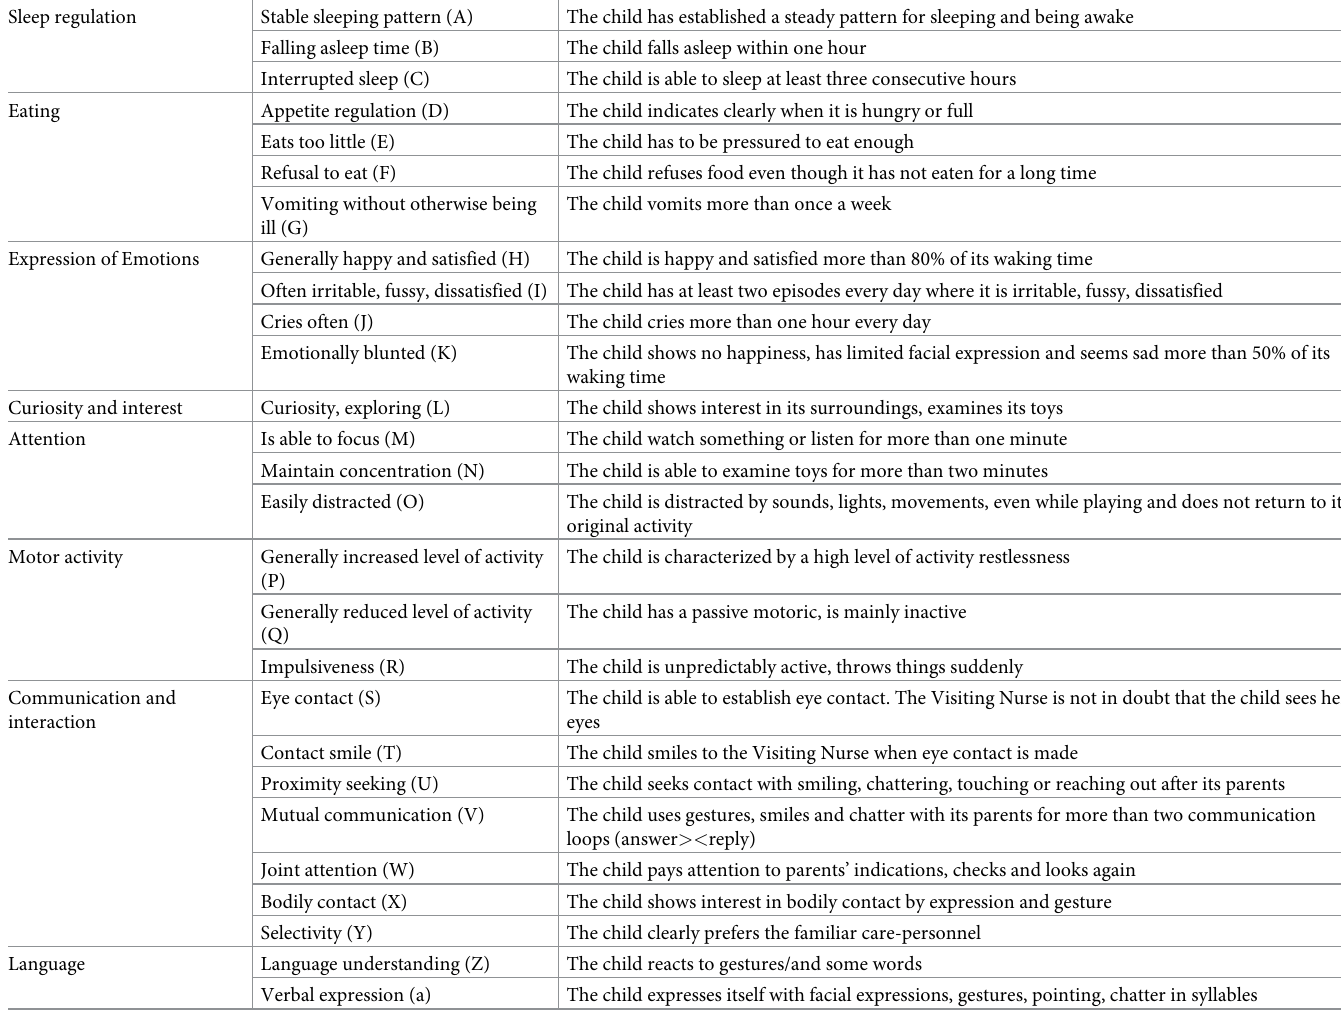
Table 1. The Copenhagen Infant Mental Health Questionnaire domains, items and descriptions of items. Sleep